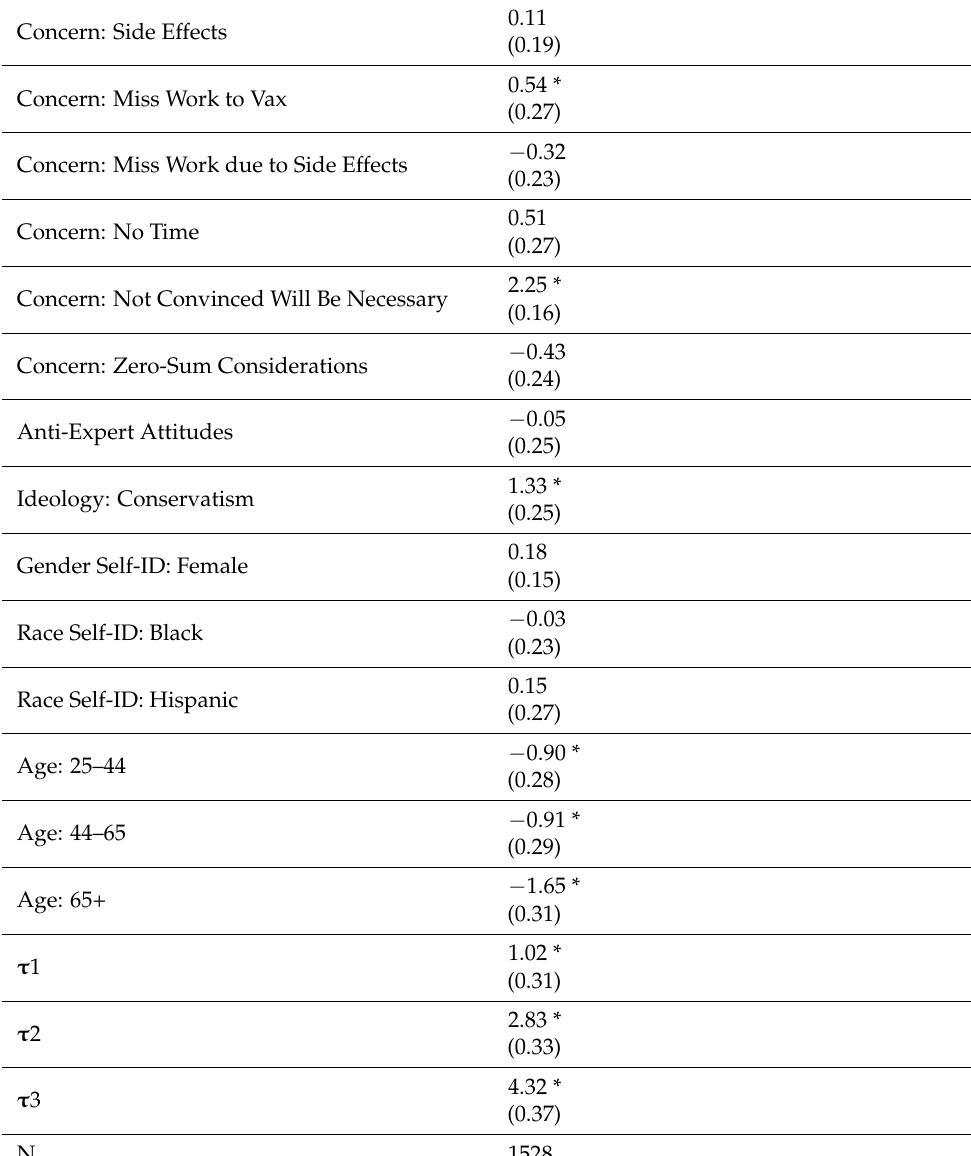
Table 2. The Effect of Concerns about Booster Vaccination on Vaccine Uptake Intentions for Americans who Received an Initial Booster